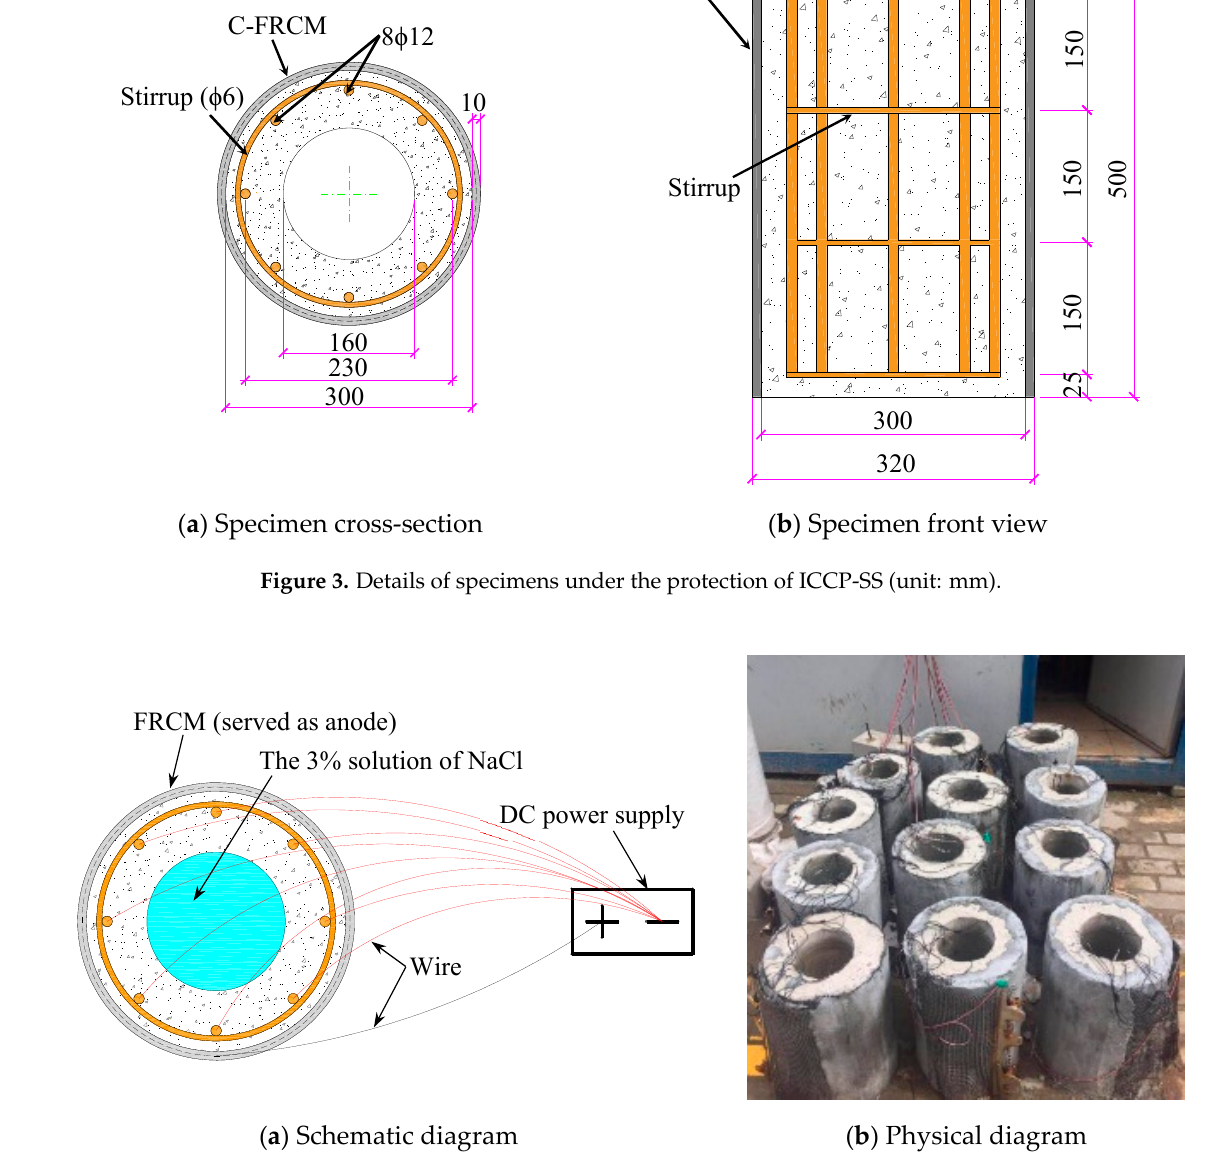
Figure 4. Schematic and physical diagrams of specimens protected by the ICCP-SS system.